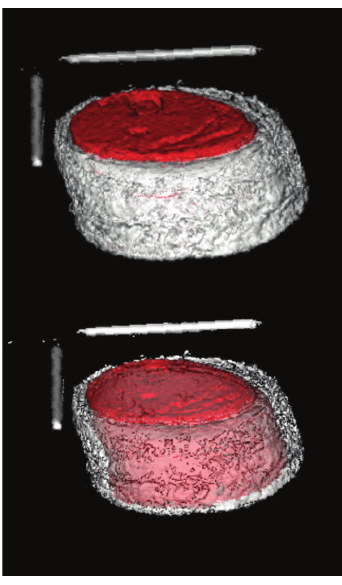
Figure 5: Volume render object map of test specimen.